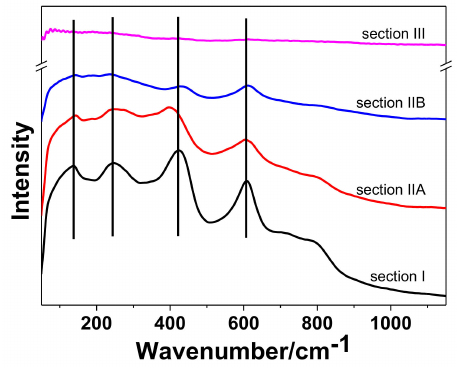
Figure 8. Raman patterns of wear surface of thermally oxidized samples in different stage as shown in Figure